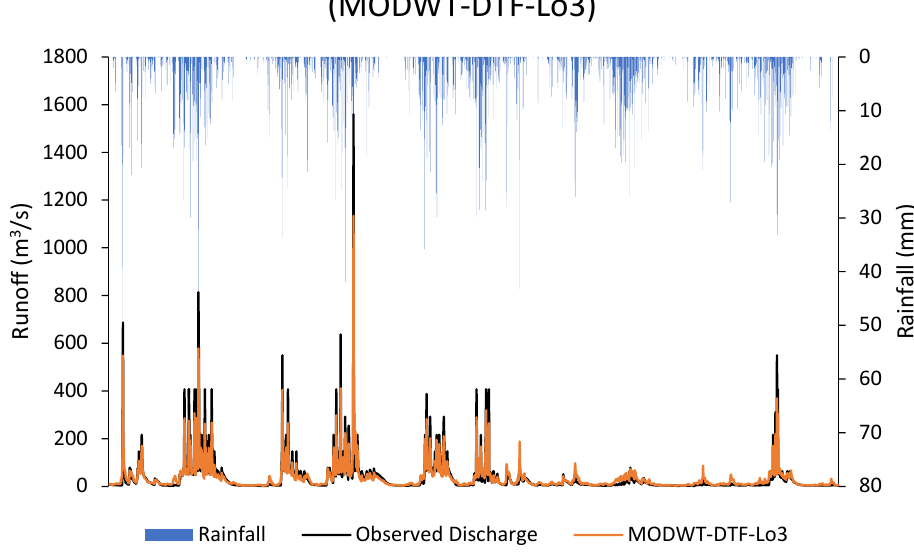
Figure 14. Rainfall–runoff modelling of Soan River basin (MODWT-DTF-Lo3).